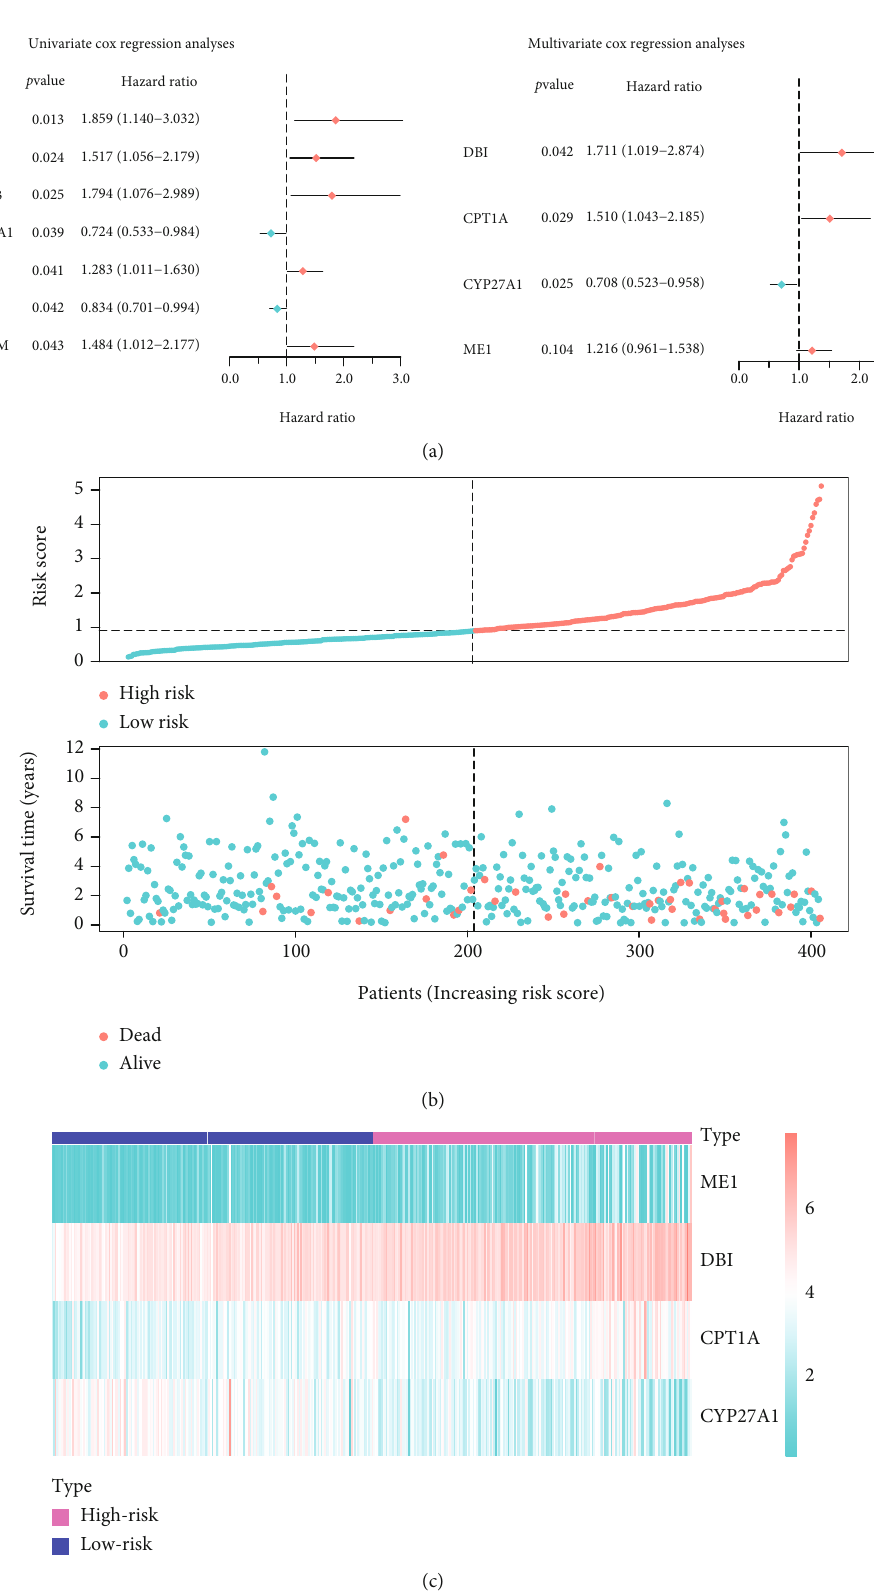
Figure 6: The construction of PPAR risk score . (a) Forest plot of the univariate and multivariate Cox regression analyses with the expression of PPAR-related gene. (b) The distribution of PPAR risk score and the survival status of patients with di ff erent scores. (c) Heatmap of the expression pro fi les of the PPAR risk score gene